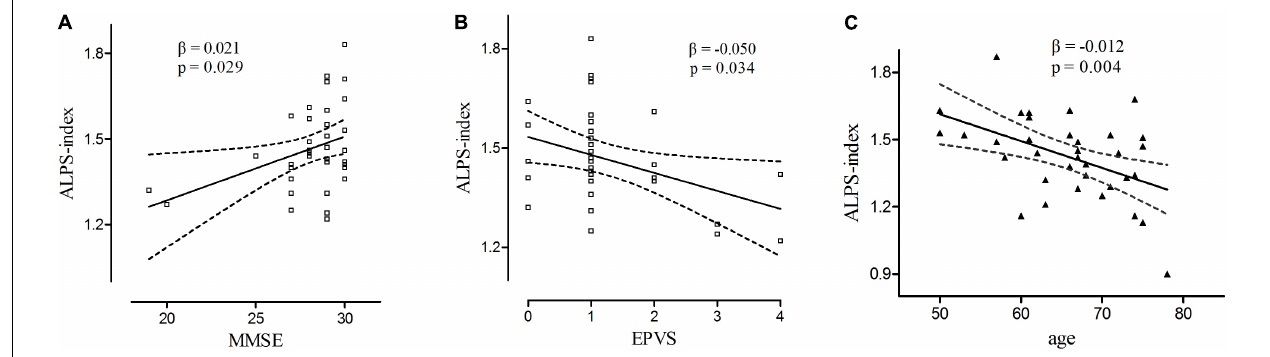
FIGURE 3 | (A) Relationships between ALPS-index and MMSE score in early PD group. (B) Relationships between ALPS-index and EPVS score in early PD group. (C) Relationships between ALPS-index and age in late PD group. Trend lines describe multivariate linear regression with 95% confidence intervals (dashed line).